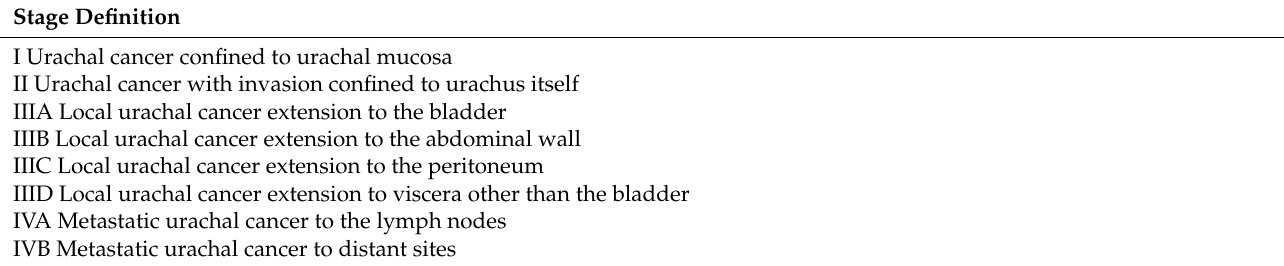
Table 2. Urachal cancer staging system as defined by Sheldon et al. [32].